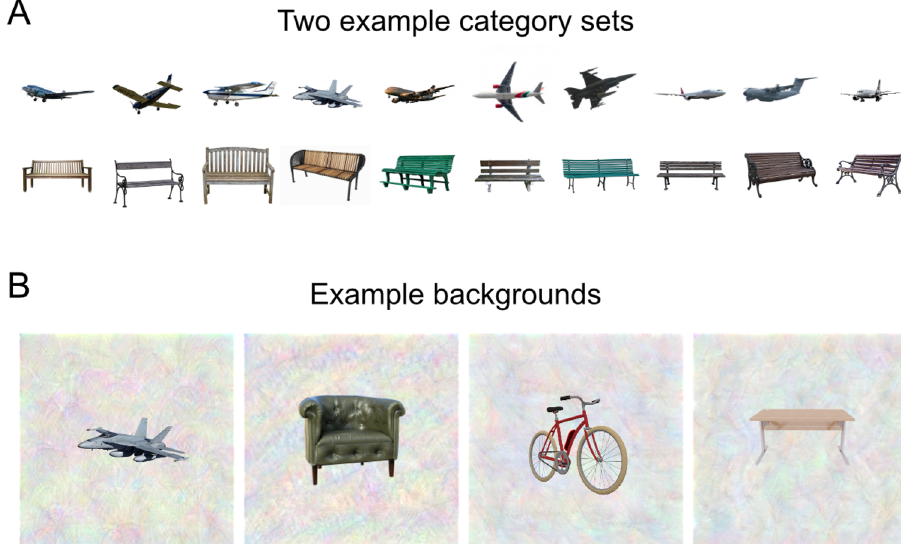
Fig. 2 Experimental stimuli. A In an fMRI experiment, subjects viewed images of isolated objects from 81 different categories. There were 10 unique tokens for each category (for a total of 810 unique stimuli). This panel shows 10 illustrative stimuli for two categories. B In the fMRI scanner, images were presented on complex, textured backgrounds to reduce the saliency of low-level features related to object shape and size. This panel shows four illustrative stimuli on textured backgrounds. All stimuli in this fi gure are shown for illustration purposes using images that we have the license to publish. They closely resemble the actual stimuli used in the fMRI experiment. Airplane image THY 9983 Nevit transparent by Nevit Dilmen is licensed under CC BY-SA